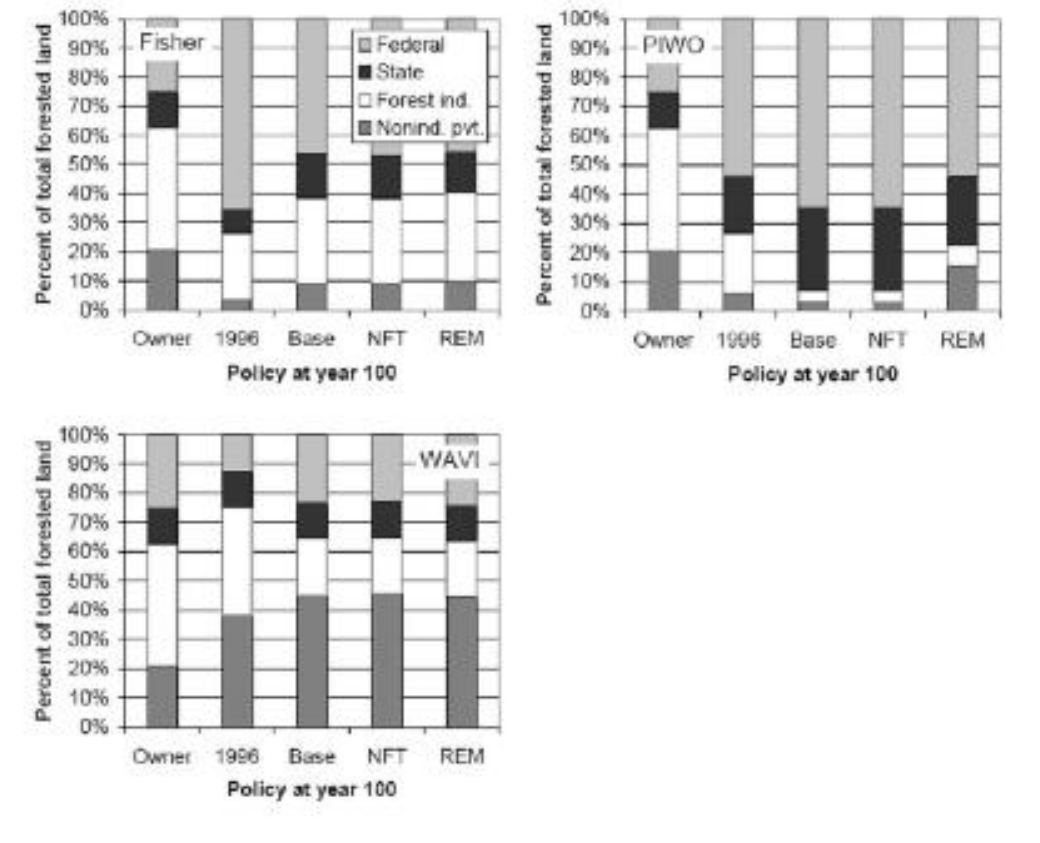
Fig. 4. Forest ownership area in the Oregon Coast Range and comparisons among current and two alternative policies in the contributions of four forest ownerships to providing habitat for three focal species 100 yr into the